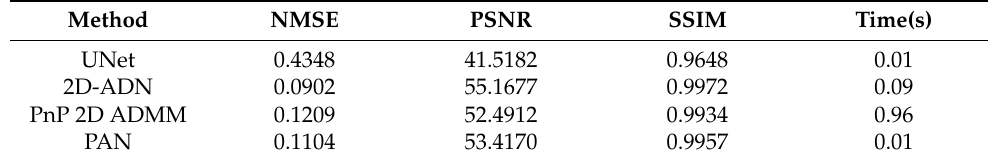
Table 3. Performance evaluation for the simulated 2D incomplete data under 15 dB Table 2. Performance evaluation for the simulated 2D incomplete data under 10 dB condition.